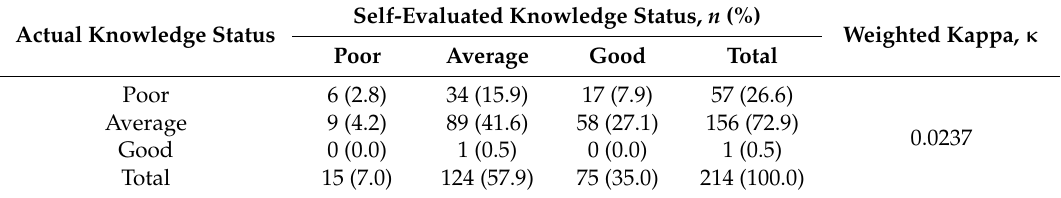
Table 4. The agreement between actual knowledge status and self-evaluated knowledge status ( n =